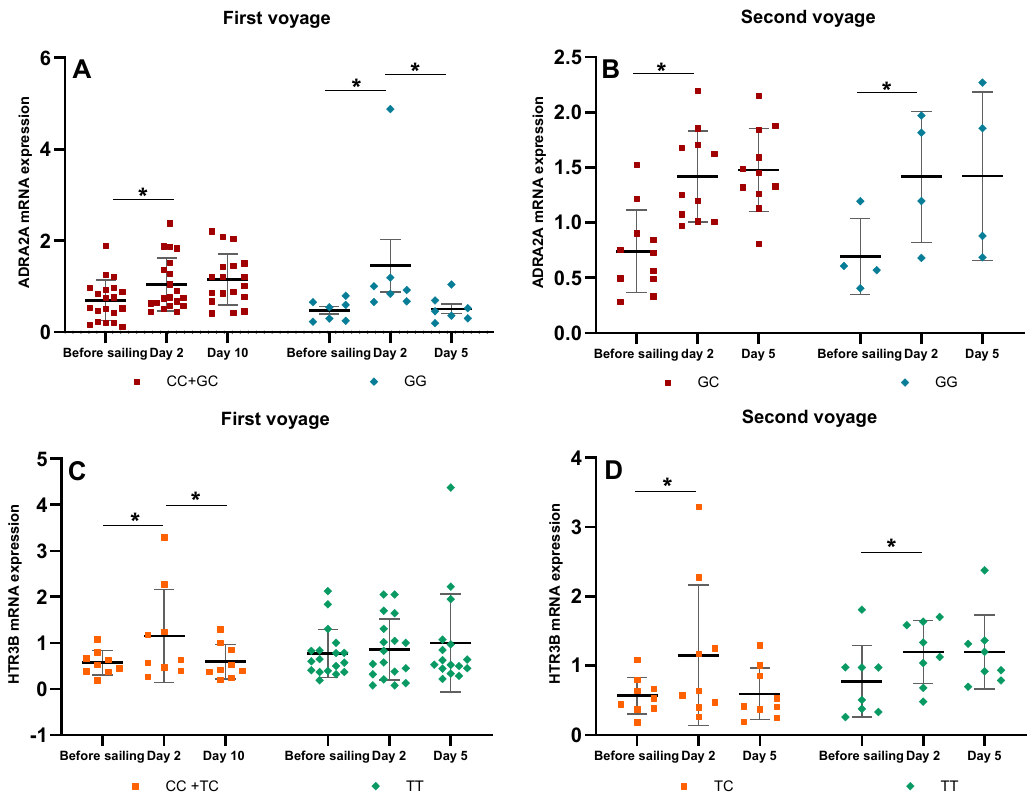
Figure 4. Dynamic changes of ADRA2A and HTR3B mRNA levels in different genotypes on the two voyages. ( A ) ADRA2A mRNA changes of rs1800544 CC+GC and GG genotypes on the first voyage; ( B ) ADRA2A mRNA changes of rs1800544 GC and GG genotypes on the second voyage; ( C ) HTR3B mRNA changes of rs3758987 CC+TC and TT genotypes on the first voyage; ( D ) HTR3B mRNA changes of rs3758987 TC and TT genotypes on the second voyage. * p < 0.05; error bar: Standard Deviation (SD).